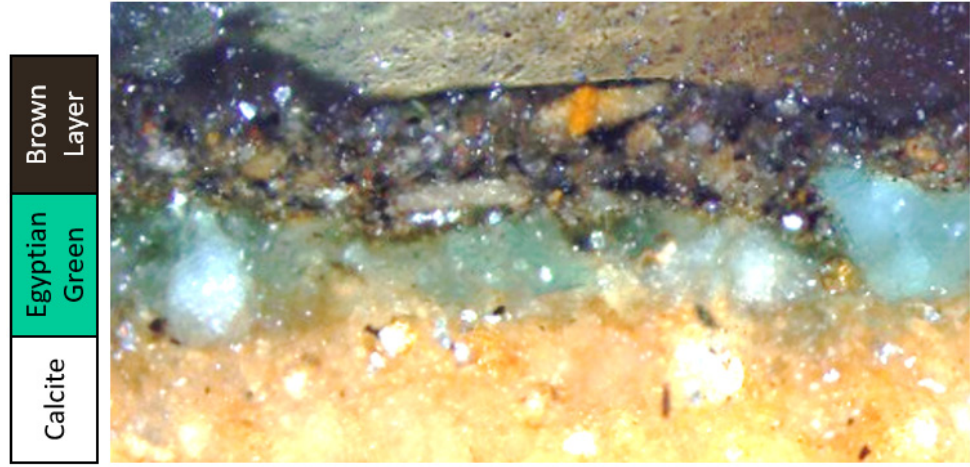
Figure 8. OM images of a details of the stratigraphy of sample B in which is highlighted the complexity of the brown layer over the Egyptian green.